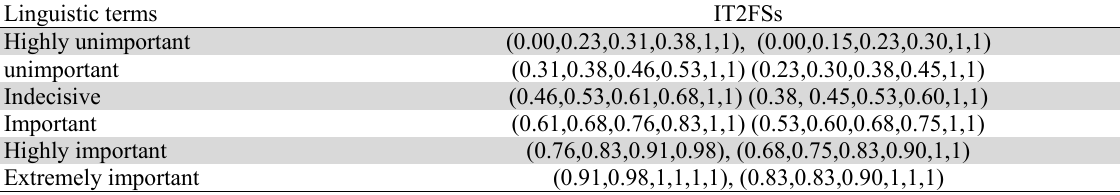
Linguistic terms and IT2FSs for the criteria weights